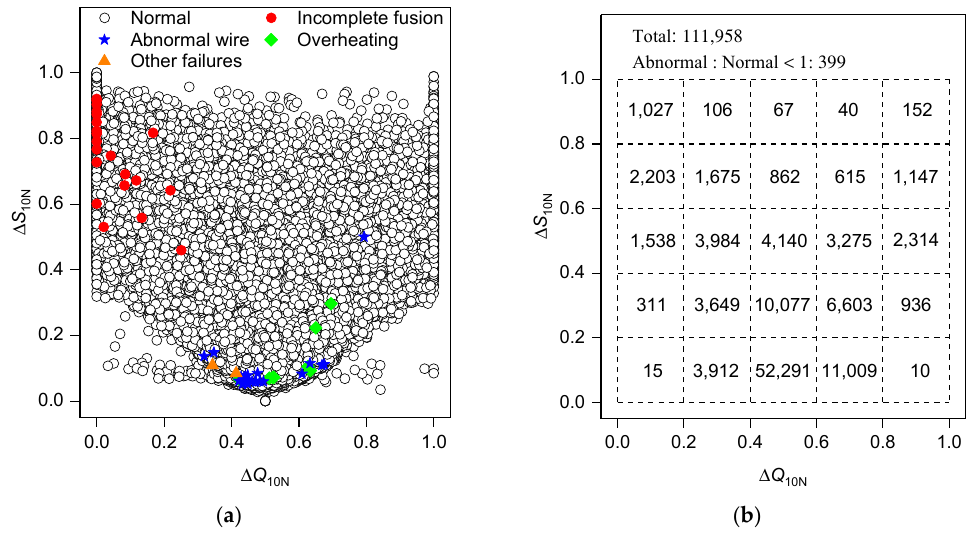
Figure 8. Feature distribution of normal welds and abnormal welds: ( a ) characteristic space; ( b ) frequency distribution.